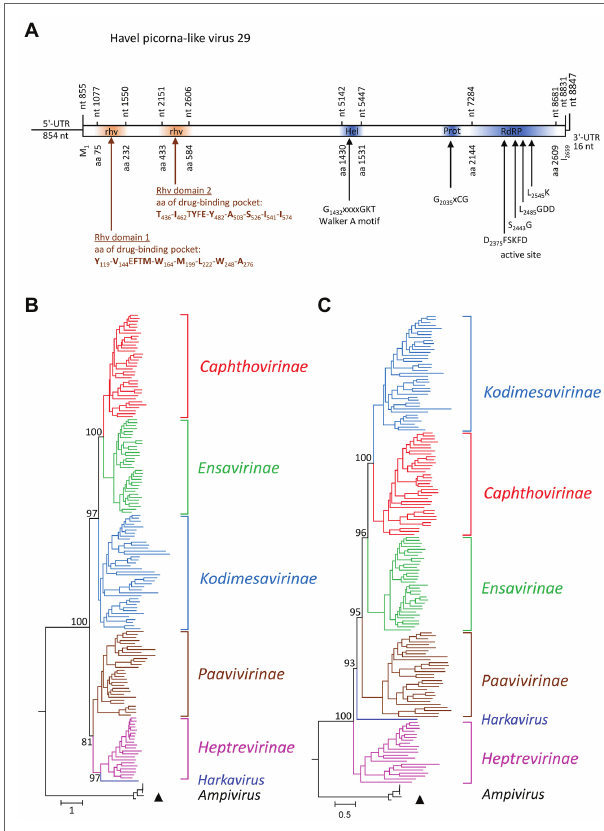
FIGURE 3 | Analysis of Havel picorna-like viruses 14 and 129. Their genome organization (A,B) corresponds to the iflavirus genome. Conserved domains and sequence motifs were identified by searching the NCBI Conserved Domain Database (https://www.ncbi.nlm.nih.gov/Structure/cdd/wrpsb.cgi). (C) Phylogenetic analysis of the complete ORF of 15 acknowledged iflaviruses and 21 candidate strains including Havel picorna-like virus 14 and 129. The tree was inferred with IQ-Tree 2, optimal substitution model: GTR + F + R5. Numbers at nodes present bootstrap values obtained after 50,000 bootstrap replications. The scale indicates substitutions per site. Presented are GenBank acc. nos. and virus names. Unassigned viruses are printed in blue. A triangle ( ▲ ) indicates the virus of the present study. UTR, untranslated region; Hel, helicase; Prot, proteinase; RdRP, polymerase; and rhv, capsid protein with similarity to the rhinovirus capsid protein with jelly roll fold and drug-binding pocket.